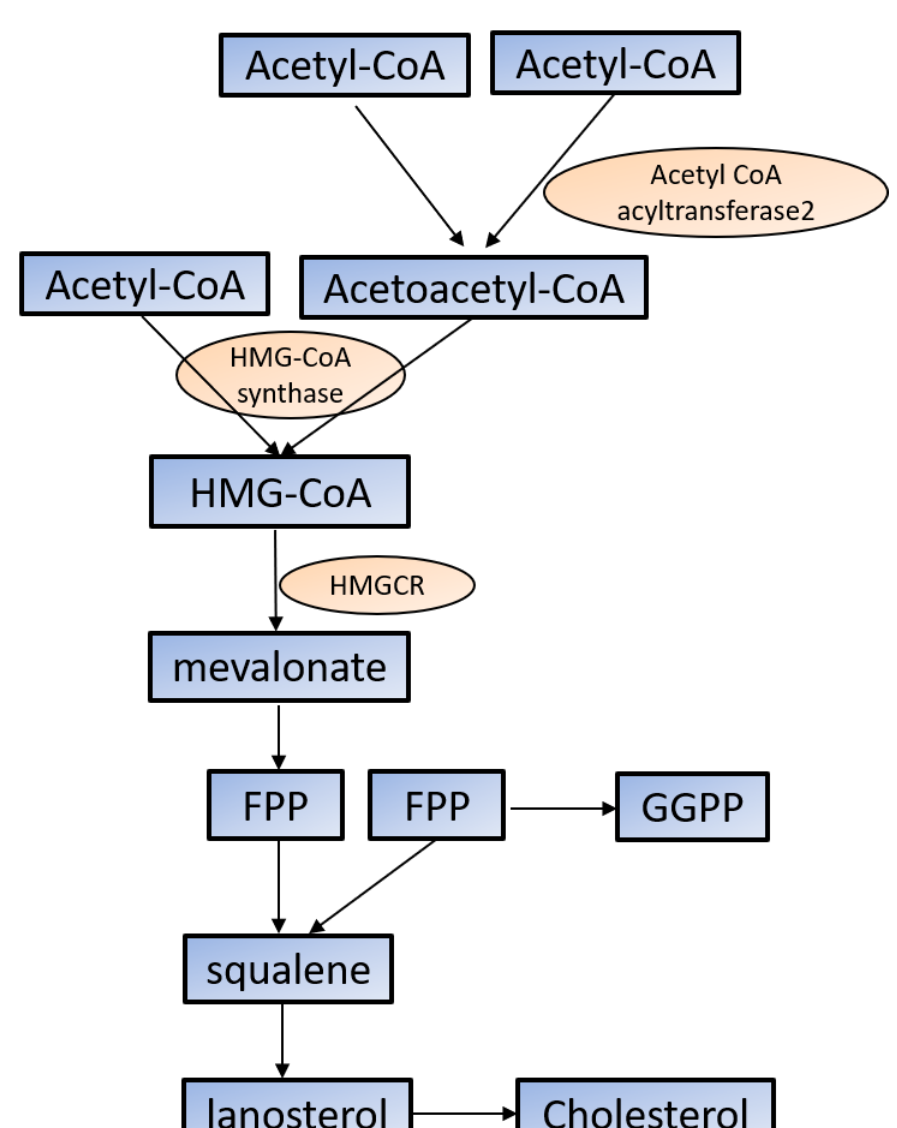
Figure 1. Cholesterol synthesis in the cytoplasm. Cholesterol biosynthesis begins with acetyl-CoA. See the text for the detailed information. HMG-CoA: 3-hydroxy-3-methylglutaryl-CoA; HMGCR: HMG-CoA reductase; FPP: farnesyl pyrophosphate; GGPP: geranylgeranyl pyrophosphate.